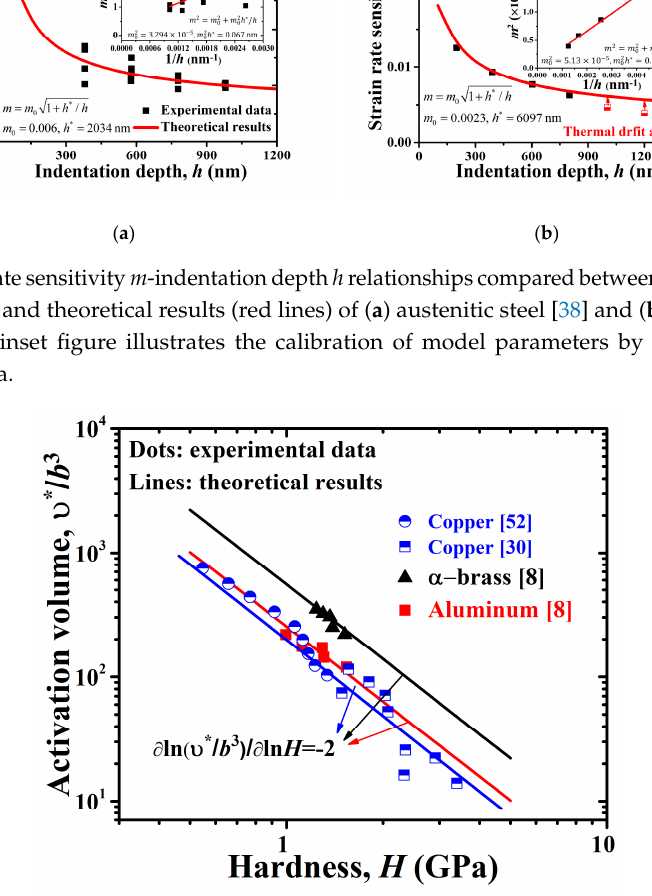
Figure 4. Normalized activation volume v ∗ / b 3 –hardness H relationships compared between experimental data (dots) and theoretical results (lines) for copper [30,52], alpha brass [8] and aluminum [8].